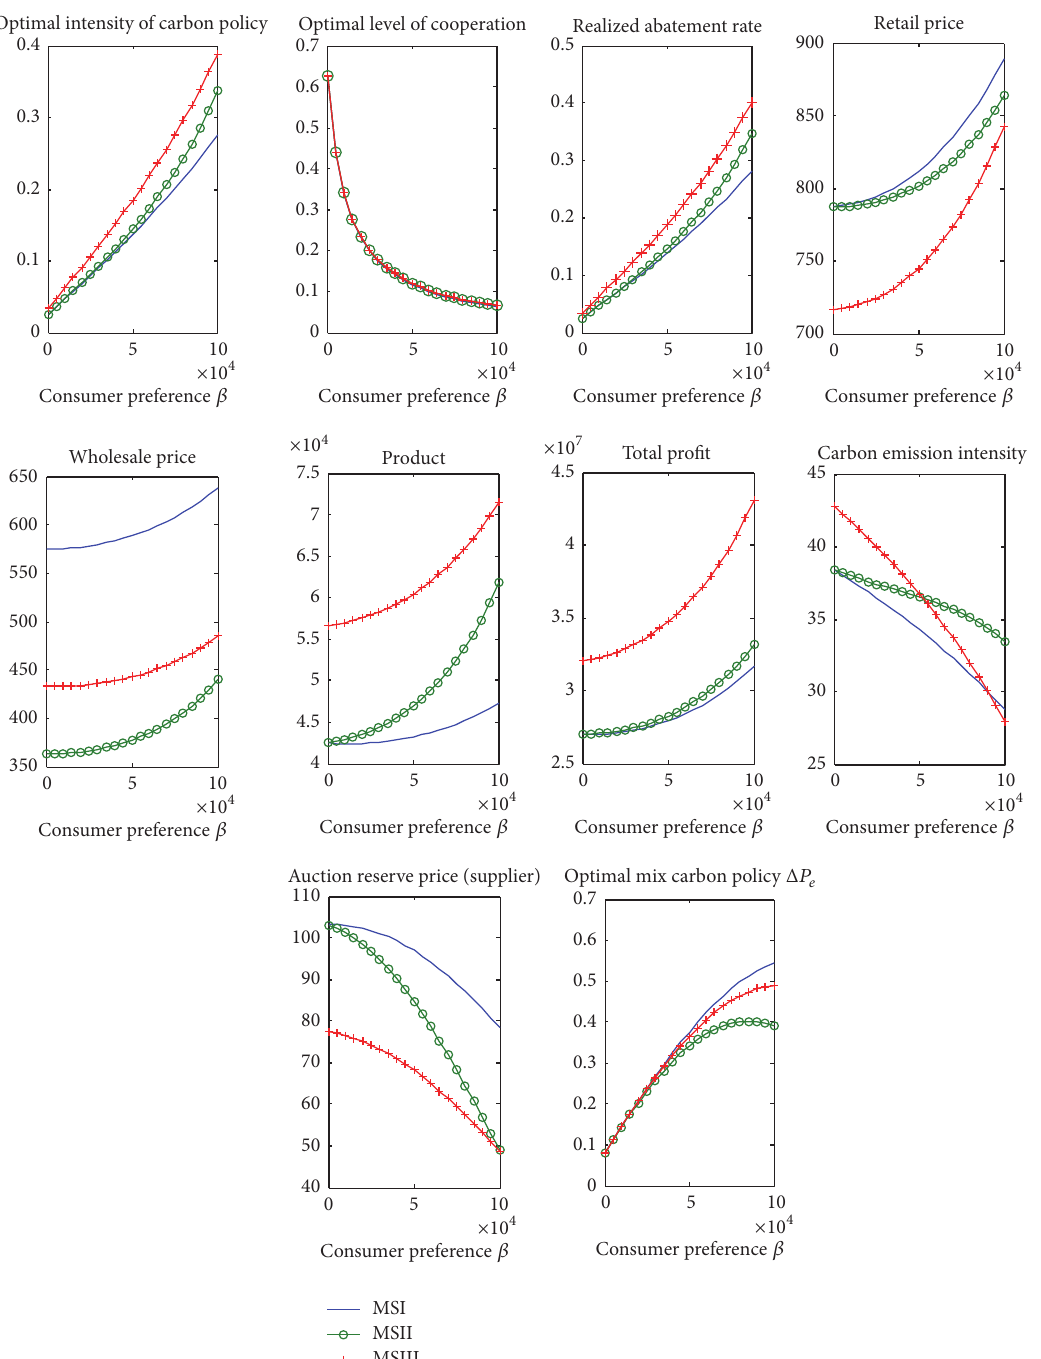
Figure 2: Changes of optimal solutions with the changes of “consumer preference 𝛽 ” with current carbon policy.